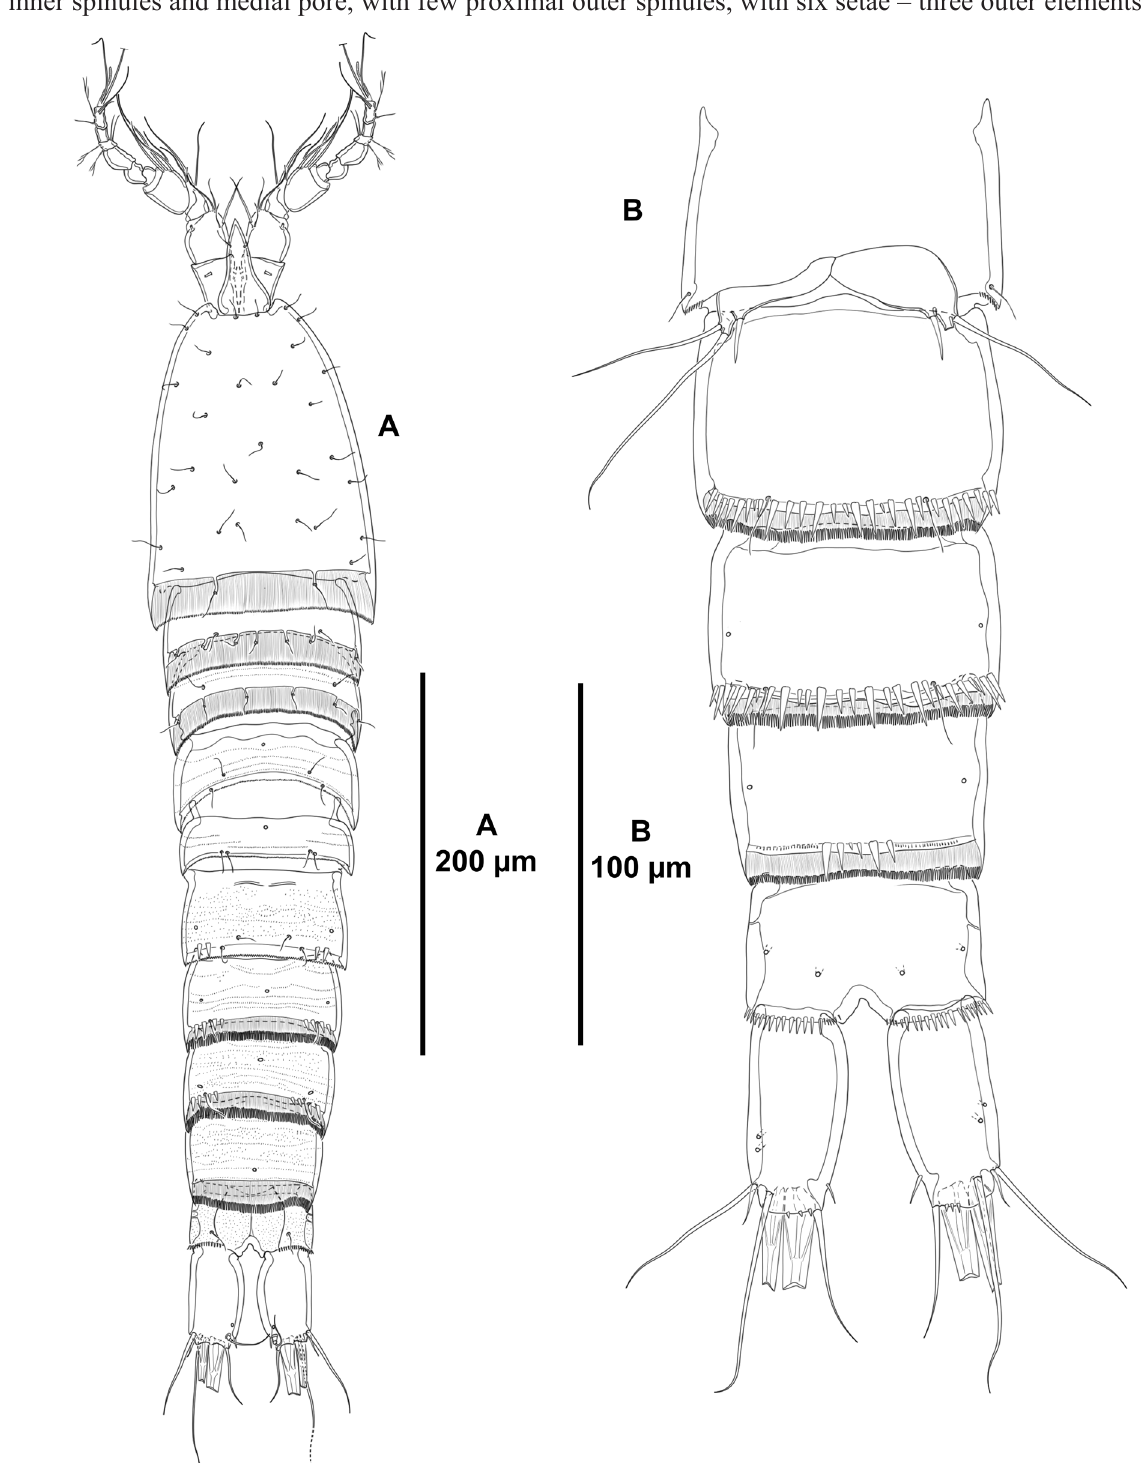
Fig. 8. Typhlamphiascus medici sp. nov. A . Allotype, ♂ (ICML-EMUCOP-180119-43); habitus, dorsal view. B . Paratype, ♂ (ICML-EMUCOP-180119-44); urosome, ventral view (P5-bearing somite